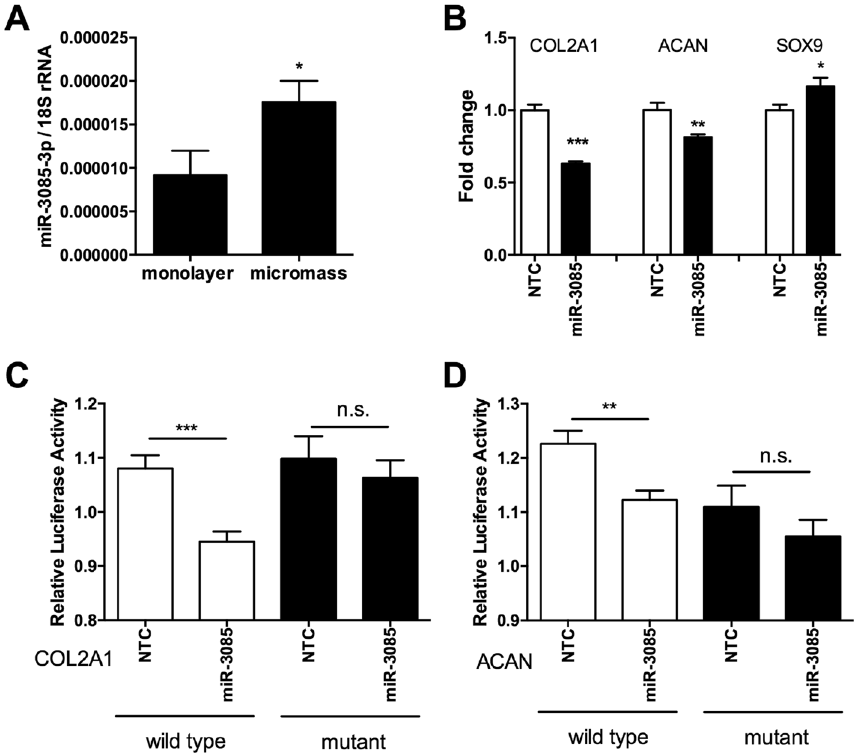
Figure 2. miR-3085 downregulates type II collagen and aggrecan expression. ( A ) Primary human articular chondrocytes were cultured in micromass culture for 48 h; miR-3085-3p was measured by qRT-PCR. ( B ) Micromass cultures of primary human articular chondrocytes transfected with miR-3085-3p mimic or non-targeting control (NTC) for 48 h; COL2A1 and ACAN were measured by qRT-PCR. SW1353 cells were transiently transfected with the ( C ). ACAN 3 ′ UTR and ( D ). COL2A1 3 ′ UTR subcloned into the pmirGLO vector (wild-type) or a construct with miR-3085-3p seed sites mutated (mutant) with miR-3085-3p mimic or non-targeting control (NTC) for 24 h. Firefly luciferase relative light units were normalised to Renilla relative light units to give overall relative light units. Mean + /− SEM, n = 3; Student’s t-test; * p < 0.05; ** p < 0.01; *** p <